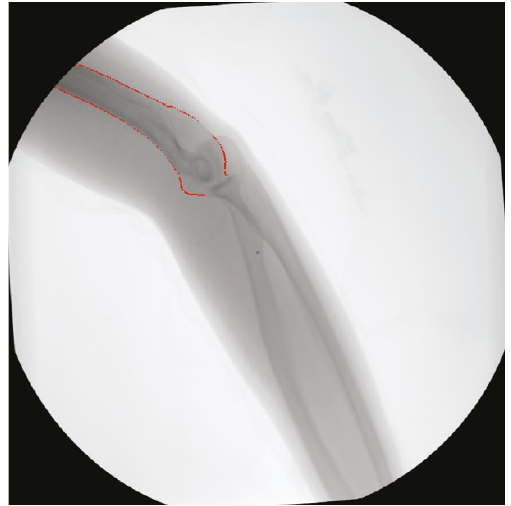
Figure 6: Real fluoroscopic image of the elbow: note the superim- position of bones and the low-contrast contours and the results of the Canny edge detection for the